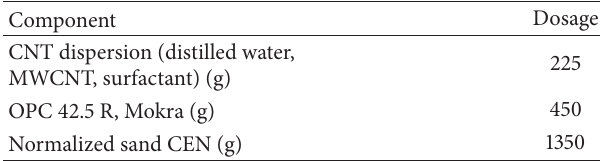
Table 6: Material composition of cement mortars with CNT. Component